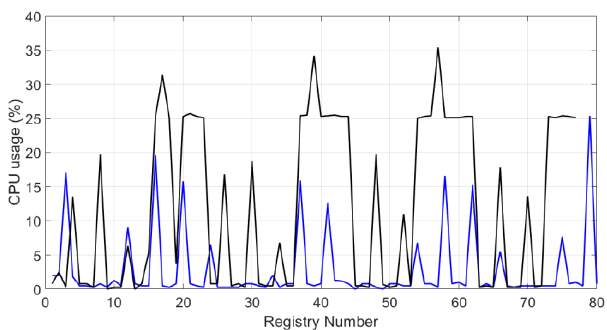
Figure 15. CPU usage percentage for test II.